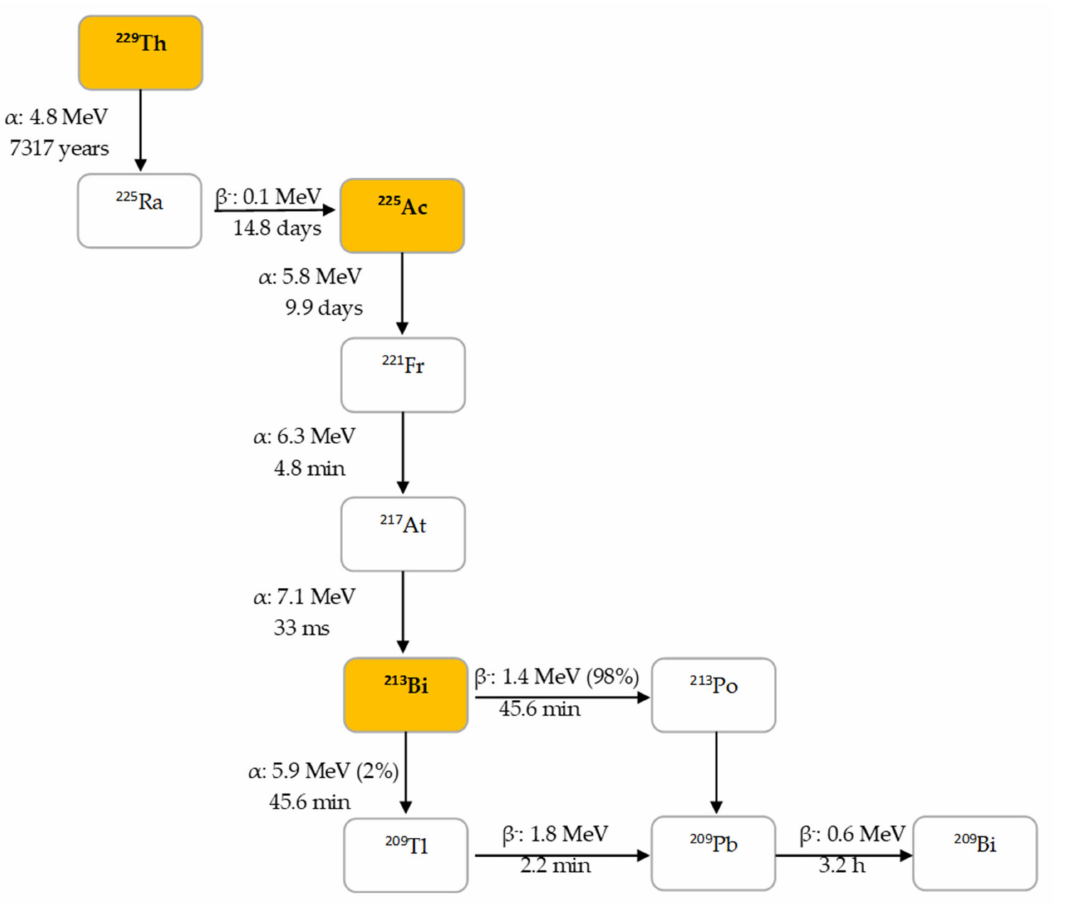
Figure 2. Decay chain of thorium-229 to 225 Ac and 213